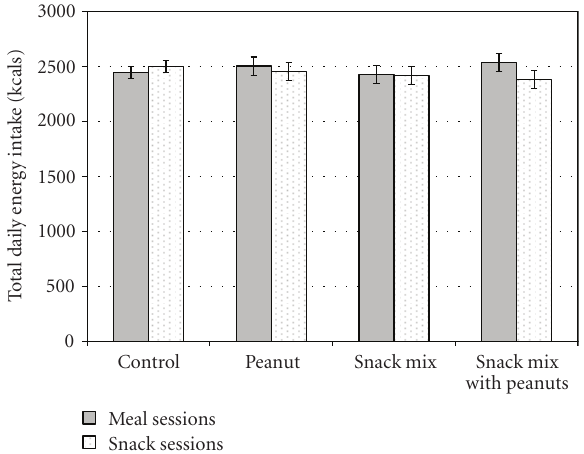
Figure 1: Mean total daily energy intake (SE) for each treatment and time combination. Peanut n = 66; Snack Mix n = 68; Snack Mix with Peanut n = 67; Control n =